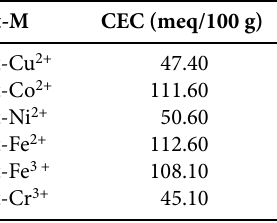
Table 2. Values of the cation exchange capacity.